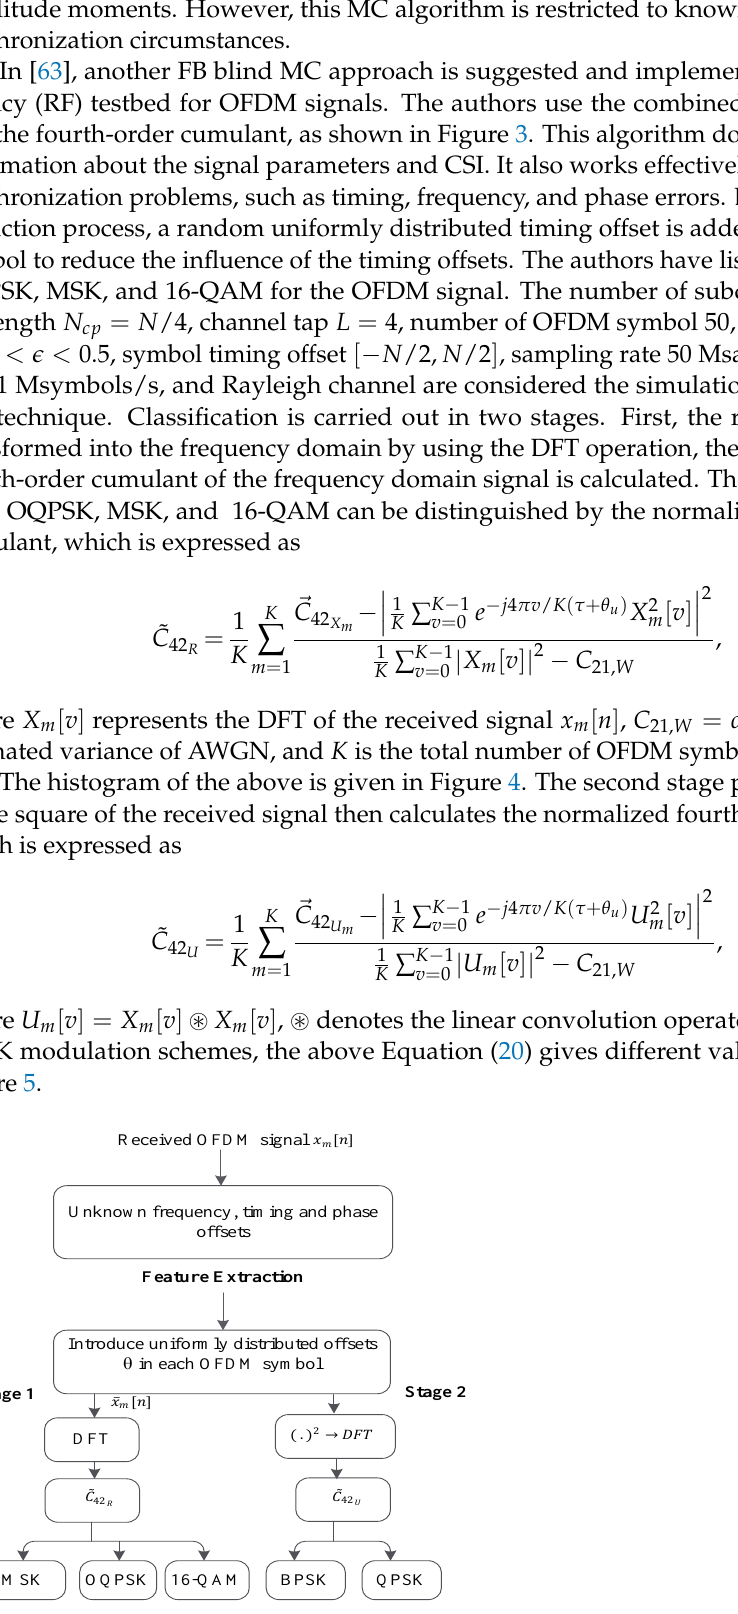
Figure 3. Schematic diagram of blind modulation classification studied in